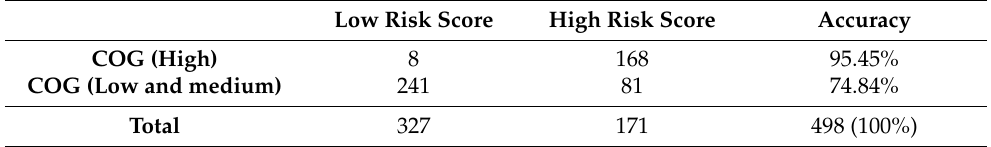
Table 3. Risk score formula grouping accuracy assessment